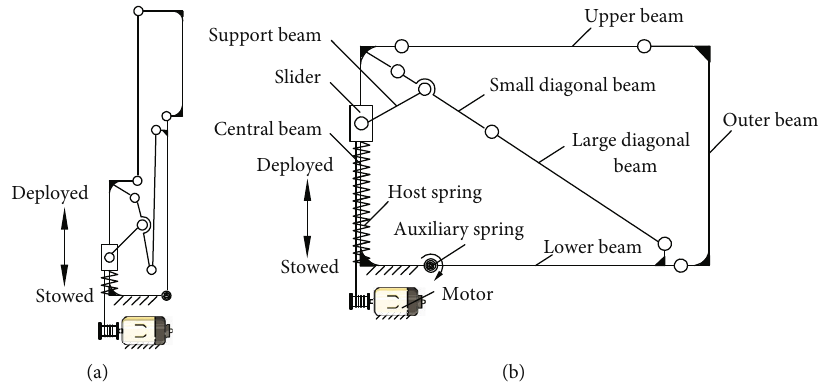
Figure 6: Structures of a rib unit. (a) Stowed. (b) Deployed.